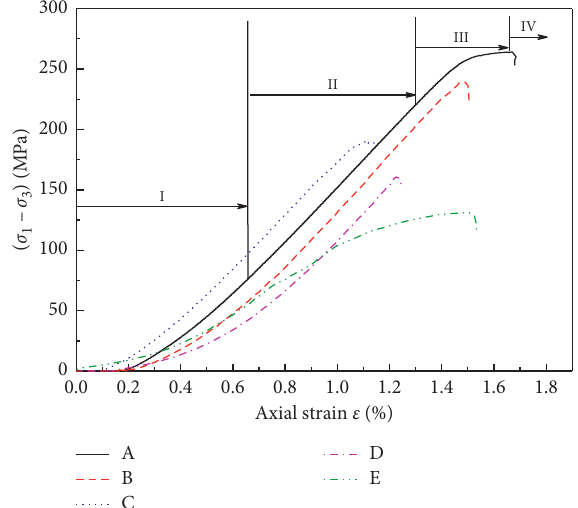
Figure 4: Stress-strain curve of granite samples. The four stages are highlighted with group